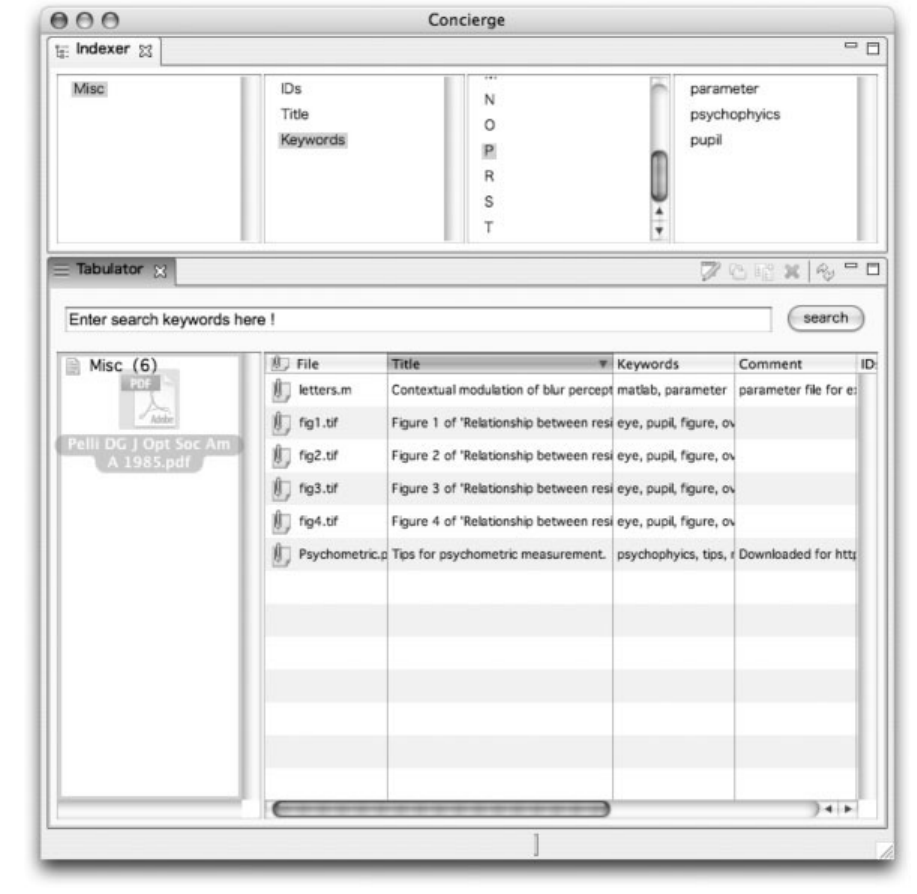
Figure 1. A screenshot of the Concierge minimum configuration . Tabulator plug-in (lower window) provides basic functions such as registration and keyword search of resources. Indexer plug-in (upper window) offers an index search function. data on the dialog. In addition, users can create a new category from the right-button menu of the Tabulator. The created category has the same metadata format as the “Misc” except for the category